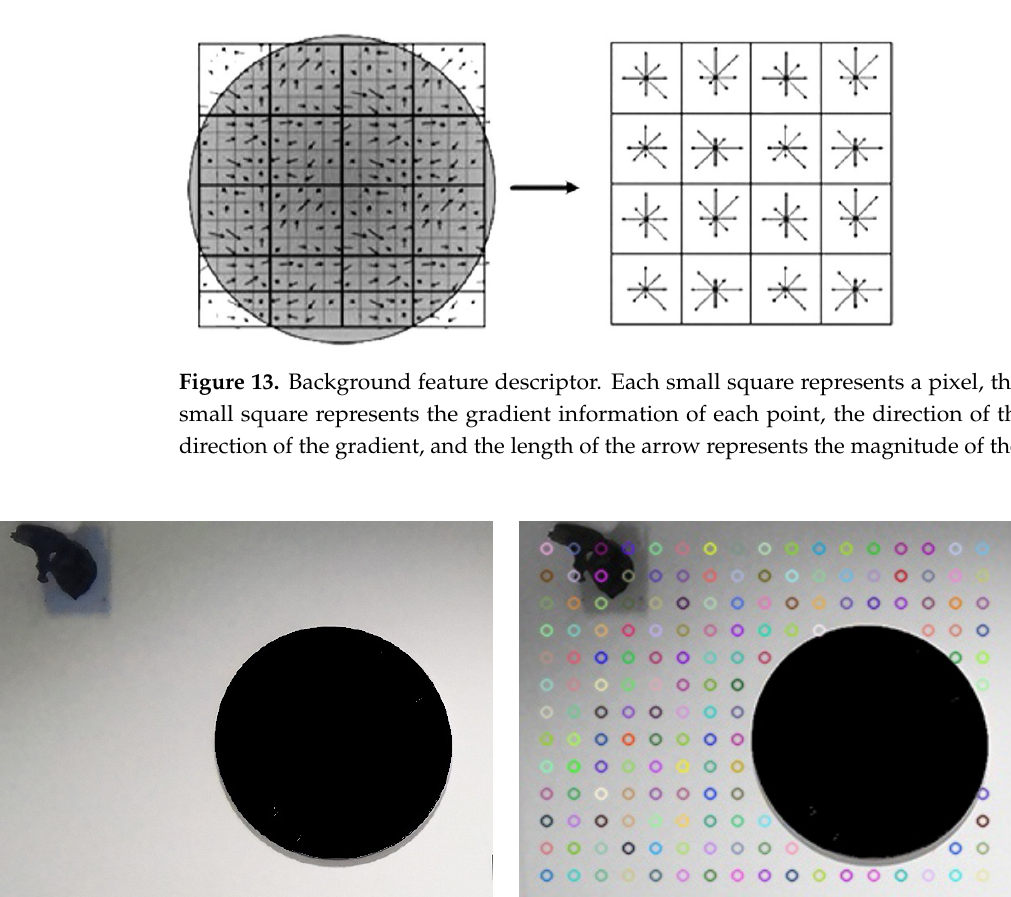
Figure 15. The actual scene and appearance of the Huiwen Building. The blue points represent the positions of some experimental images on the exterior of the building. Some areas of the teaching building are displayed in four panoramic pictures on the right according to the corresponding colours.